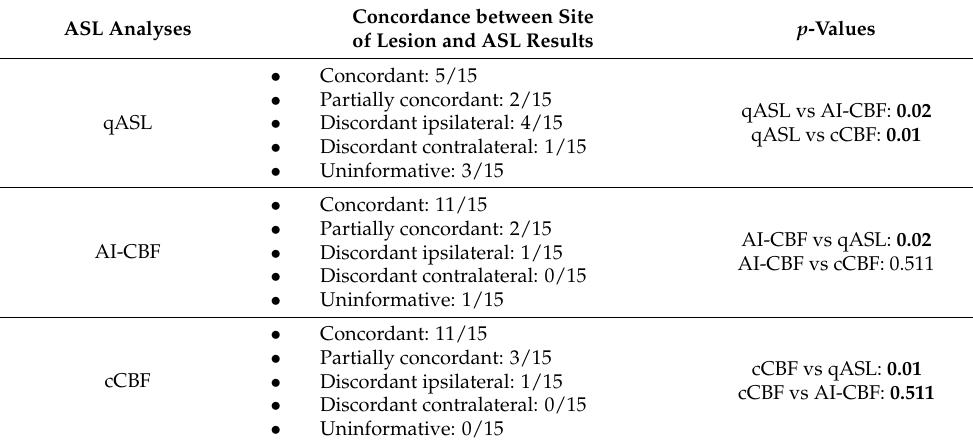
Note p -values indicate statistical levels in post-hoc analysis based on the analysis of adjusted standardized